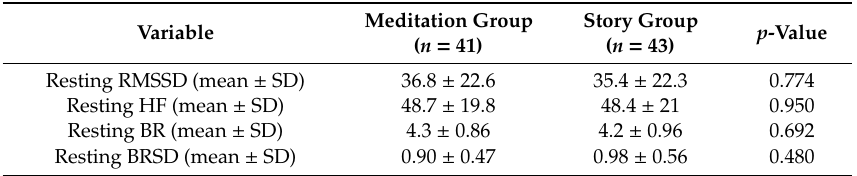
Table 2. Descriptive statistics of the two study groups within the whole sample ( n = 84) for the resting state, the interventions (Meditation vs. story) and the a path calculated as the di ff erence in variables between intervention and resting state (Di ff